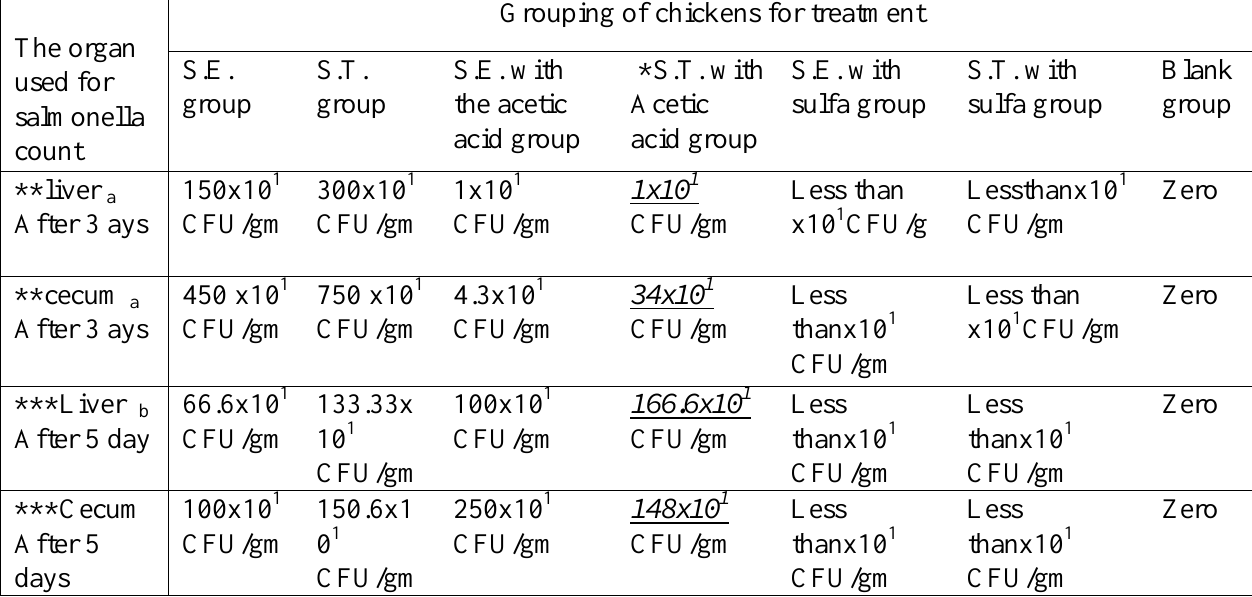
Table 5: Mean of most probable number (MPN) of salmonella count after sulfa and acetic acid